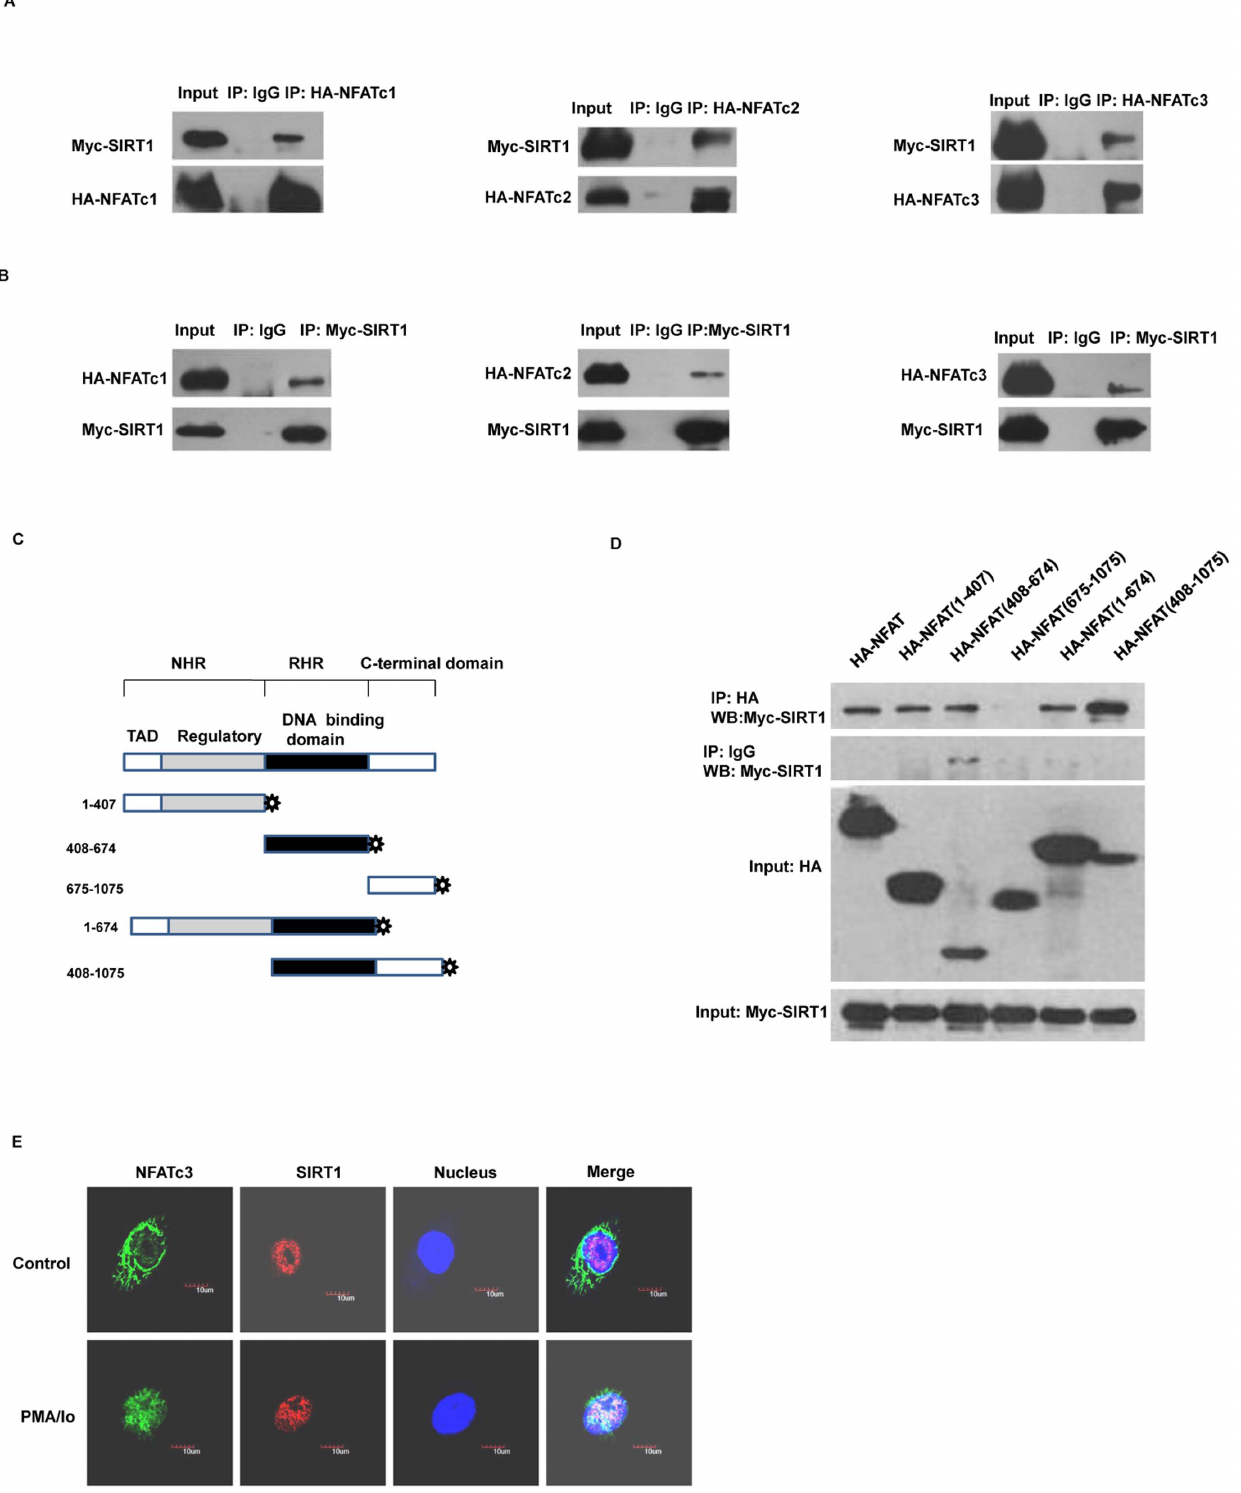
Figure 2. SIRT1 interacts with NFAT. (A, B) HEK 293 cells were co-transfected with a Myc-tagged of SIRT1 and HA-tagged of NFAT expression vectors, and were analyzed using co-immunoprecipitation and western blotting. The images are representative of three independent experiments. (C) Schematic diagram of full-length or truncated NFATc3 is shown. NHR, NFAT homology region; RHR, Rel homology region; TAD, transactivation domain. (D) HEK293 cells were transfected with HA-tagged either full-length or truncated NFATc3 and Myc-tagged SIRT1 expression vectors for 24 h and were lysed for co-immunoprecipitation and western blotting. The images are representative of three independent experiments. (E) HUVECs were treated with PMA (10 ng/ml) and Io (0.25 m M) or vehicle DMSO for 1 h. Immunofluorescence experiments were done with anti-NFATc3 and